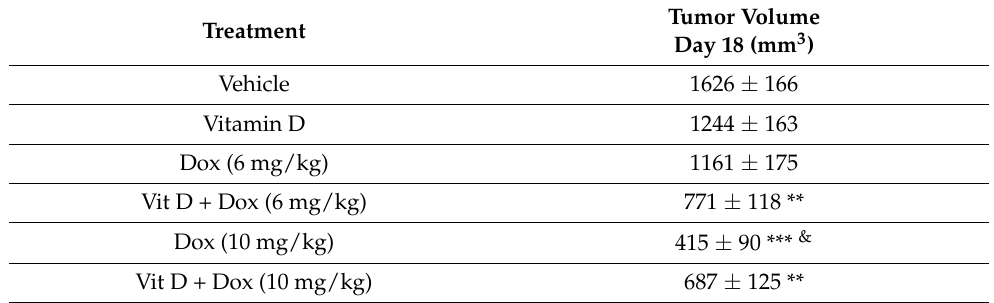
Table 2. Tumor volume at day